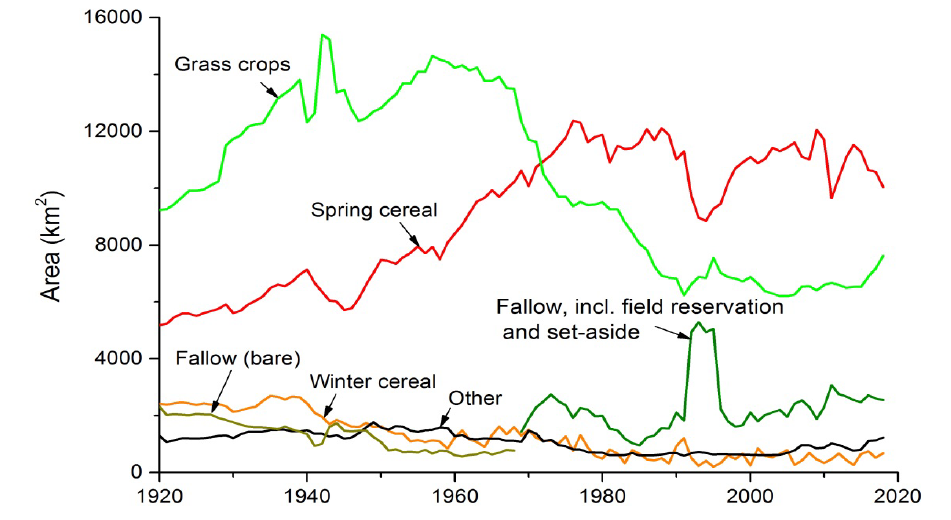
Fig. 1. Use of arable land in Finland in 1920–2018 (Tiainen 2004 and unpubl., based on annual farm statistics of Official Statistics of Finland). Grass crops include dry hay, green fodder, silage and cultivation of hay and clover seed (see Fig. 2). Spring cereal combines spring wheat, oat, barley and mixed cereal. Winter cereal combines winter wheat and rye. Other includes, among other minor crops, potato and oilseed and turnip rape. Fallows were mostly used for mechanical control of weeds to the end of the 1960s and were thus interpreted to be mainly bare. Since 1969 there have been several phases of reducing overproduction with fallowing, like the field reservation program from 1969 to the late 1970s and early 1980s, obligatory green-fallowing in 1991–1994, and 10% obligatory fallowing during 1995–2007; these fields were mostly established with grass. Since 2008, farmers have been able to make agri-environmental commitments about nature management field